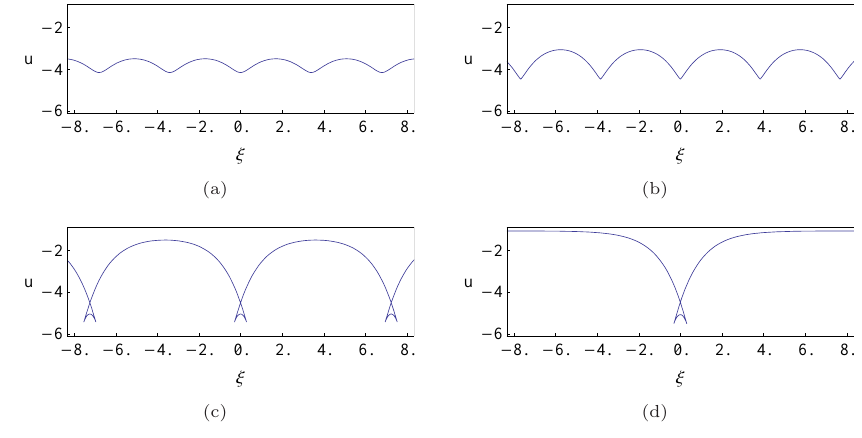
Figure 2. The smooth periodic wave, periodic cusp wave, periodic cusp loop wave and cusp loop solitary wave of Eq. (1.1) with c = 20 and g = − 20: (a) ϕ 0 = − 3 . 5, (b) ϕ 0 = ϕ −√ c , (c) ϕ 0 = − 1 . 5, (d) ϕ 0 = ϕ 2